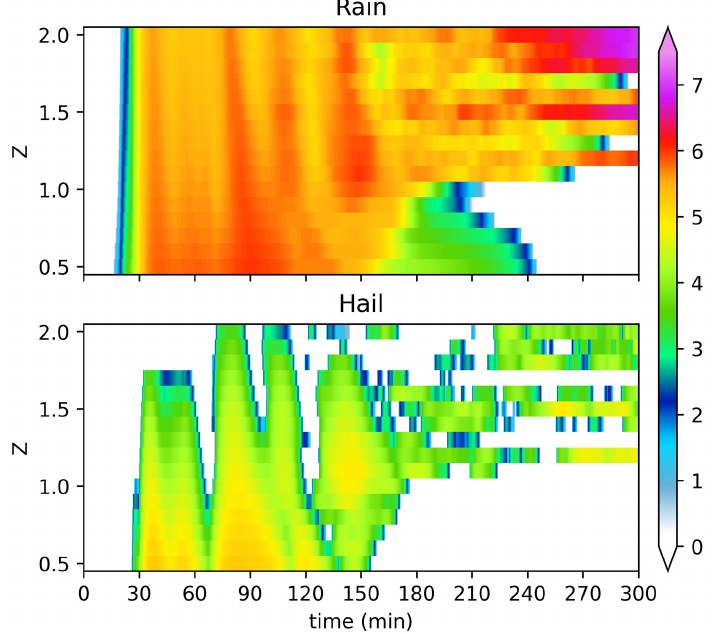
Figure 1. Temporal variation of the domain total precipitation intensity R (kg/s) of the rain and hail categories in the simulated storm with the Z factor for small domain simulations. The color scale is in units of 𝑙𝑜𝑔 (cid:2869)(cid:2868) 𝑅 .